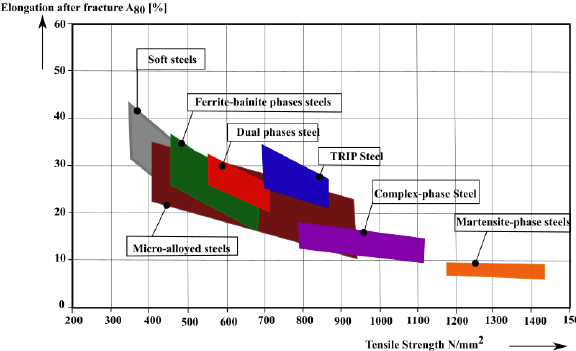
Figure 1: Example selection and properties of currently common hot- rolled high-strength steels for automotive production. G. Schulze // Heidelberg-Dordrecht. (2009). ©2009 Springer